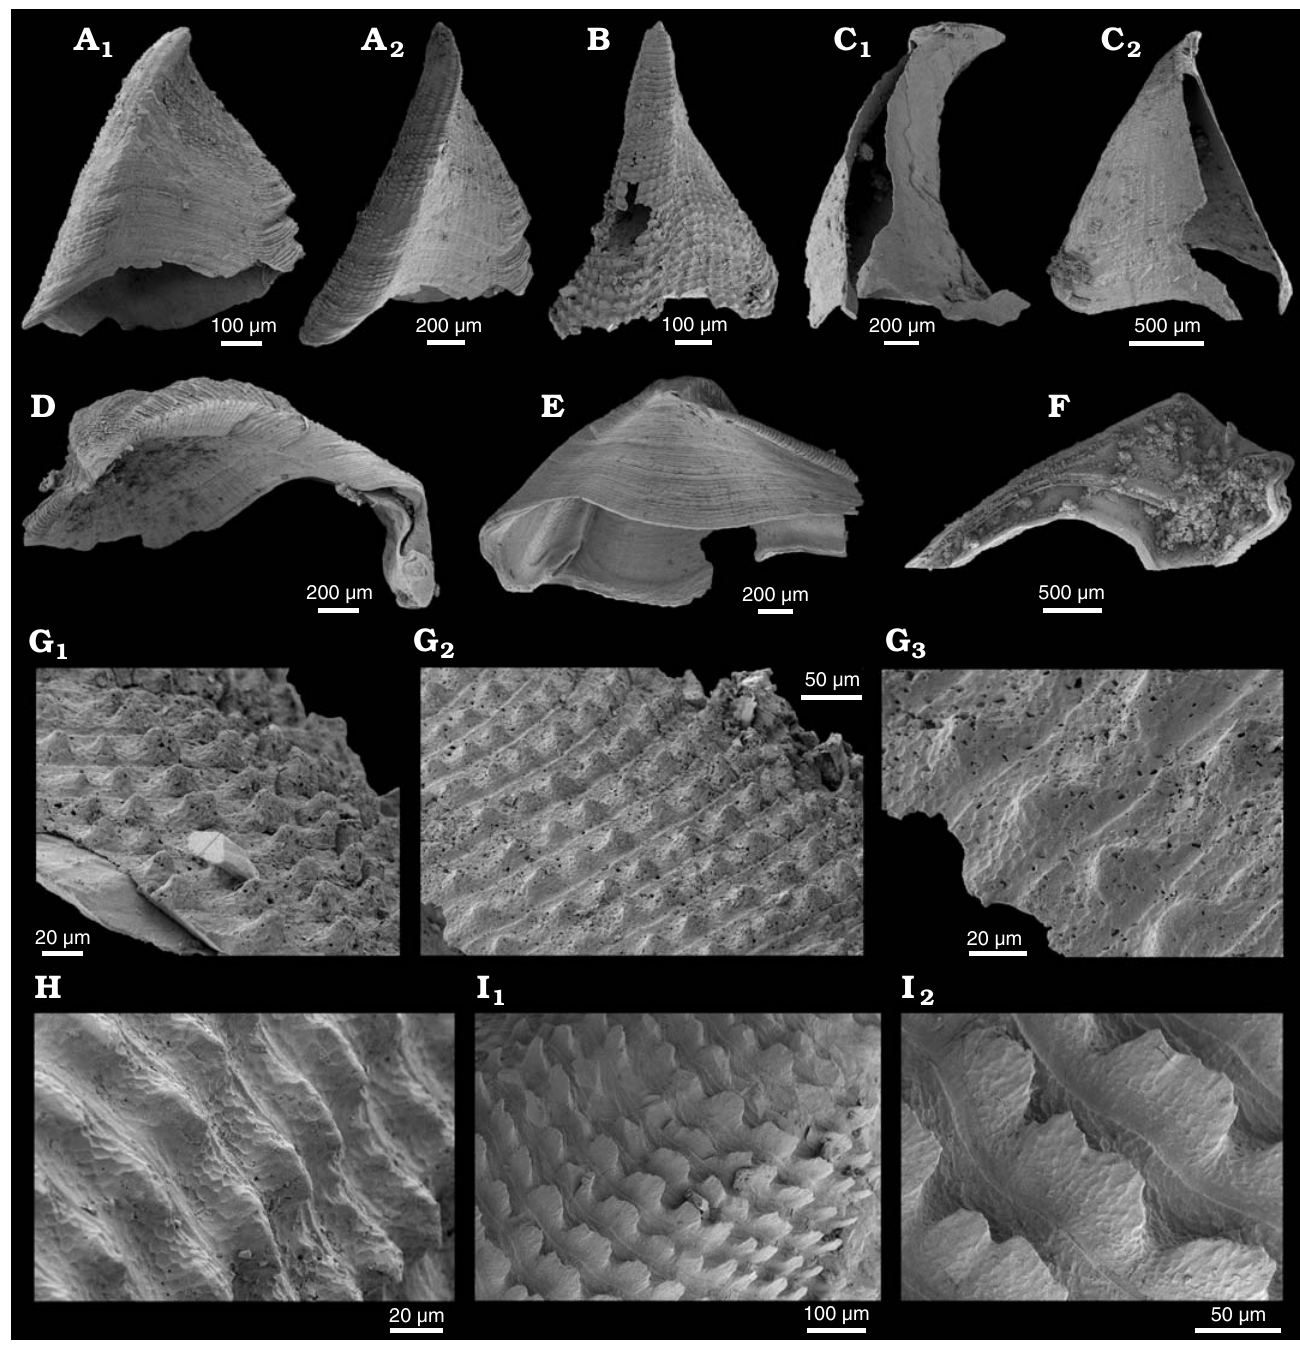
Fig. 17. C2 sclerites of the camenellan tommotiid Dailyatia decobruta Betts sp. nov. from the lower Cambrian White Point Conglomerate, Kangaroo Island, South Australia. A . SAM P57352 in lateral view; A 1 , A 2 show slightly different angles to capture three dimensionality of sclerite. B . SAM P57353 in lateral view. C . SAM P57354 in dorsal view; C 1 , C 2 show slightly different angles to capture three dimensionality of sclerite. D . SAM P57355 in ventral view. E . SAM P57356 in ventral view. F . SAM P57357 in ventral view. G . SAM P57358, G 1 –G 3 , close ups of external ornament. H . SAM P57348, close up of external ornament. I . SAM P57359, holotype; I 1 , I 2 , close ups of external